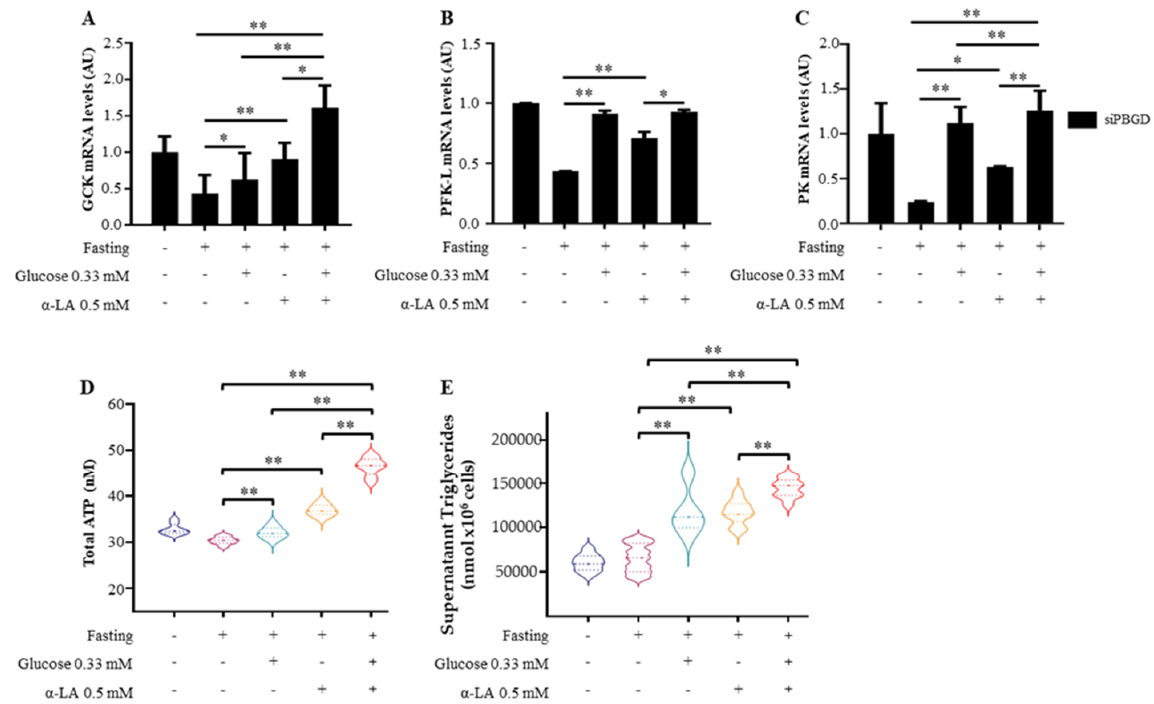
Figure 2. α -LA improved glucose utilization in PBGD-silenced HepG2 cells. ( A – C ) GCK, PFK-L and PK mRNA expression was measured in siPBGD cells at baseline, after fasting and in presence of glucose, α -LA or both treatments. ( D ) Intracellular ATP was measured in siPBGD cells and compared to fasting, siPBGD + Gluc, siPBGD + α -LA and to the combined treatment according to manufacturer ‘instruction. ( E ) Measurement of triglyceride secreted in cell supernatants of siPBGD cells with or without fasting and pre-treated with glucose, α -LA and α -LA + Gluc. For gene expression, data were normalized to ACTB housekeeping gene and expressed as fold increase (Arbitrary Unit-AU) compared to control group. For violin plot, data were expressed as median concentration (thick dashed lines) and interquartile range (dotted lines). At least three independent experiments were conducted. Adjusted * p < 0.05 and ** p < 0.01.